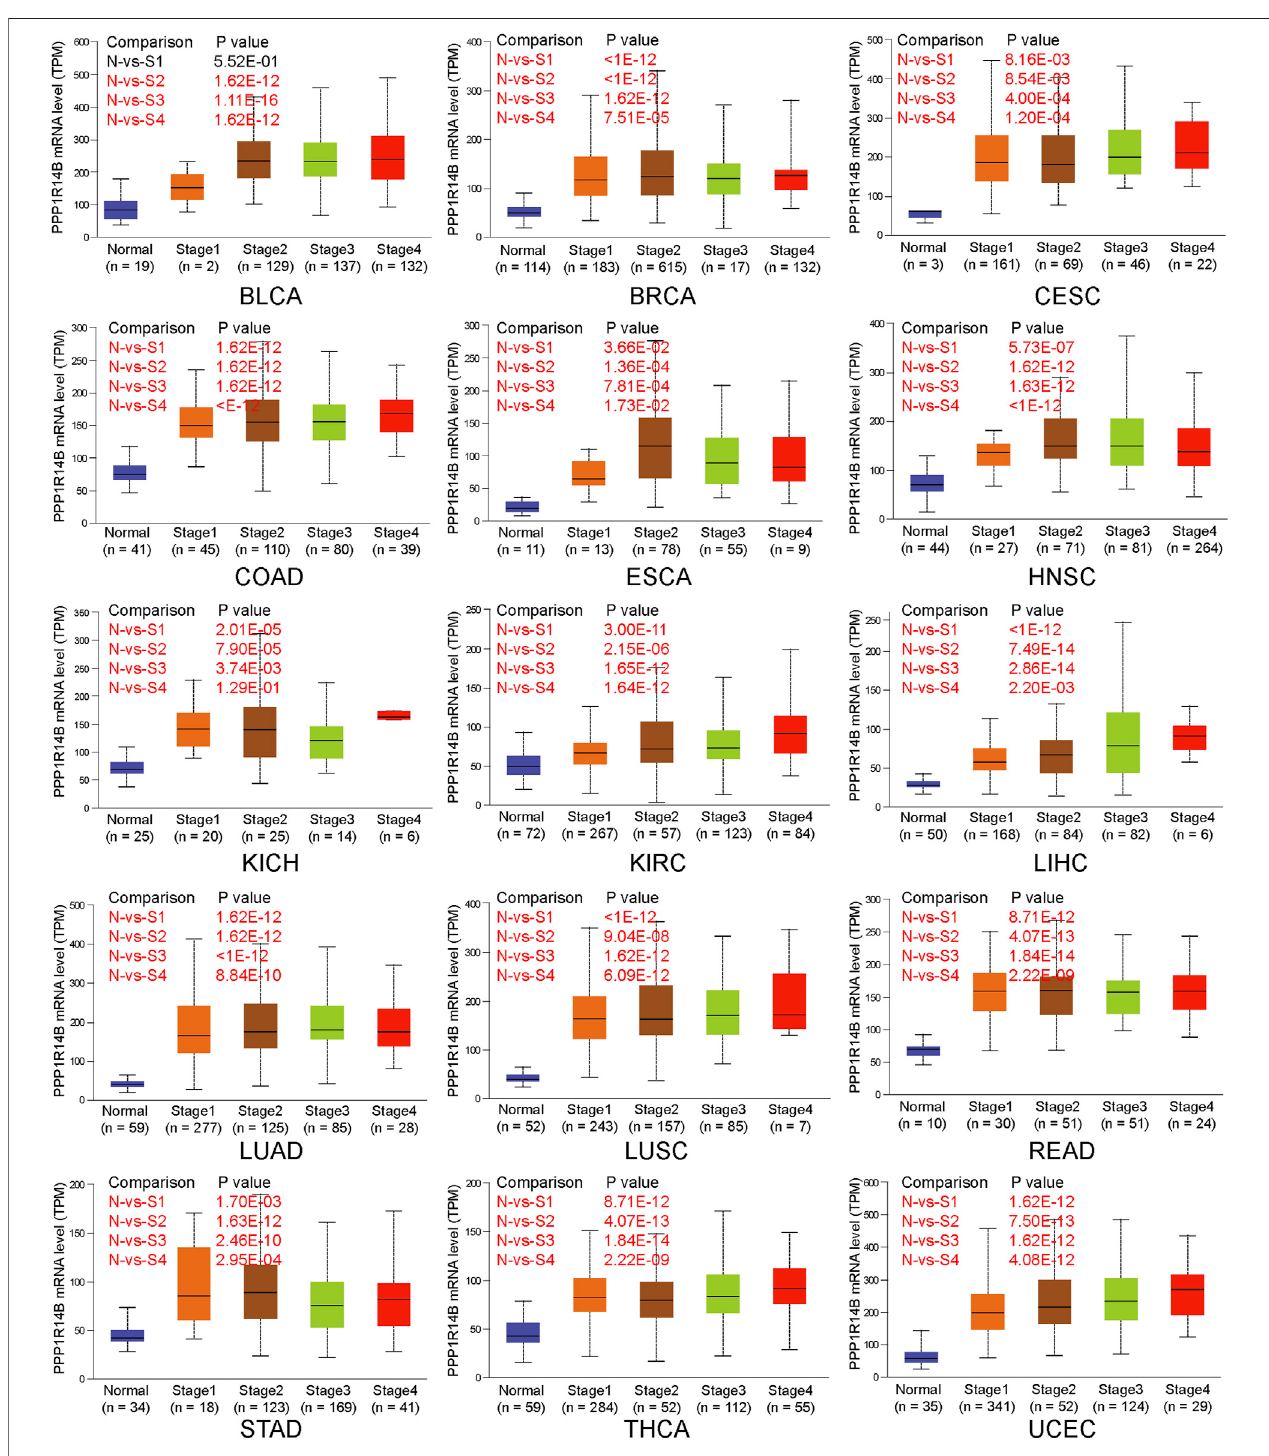
FIGURE 3 | PPP1R14B overexpression in different pathologic stages. The expression of PPP1R14B according to the pathologic stage of the patient in the TCGA cancer type in the UALCAN database. X axis: pathologic cancer stages with the number of samples in each stage. Y axis: transcript per million. N, normal; S, stage. p -value marked red means the two groups are statistically signi fi cant.